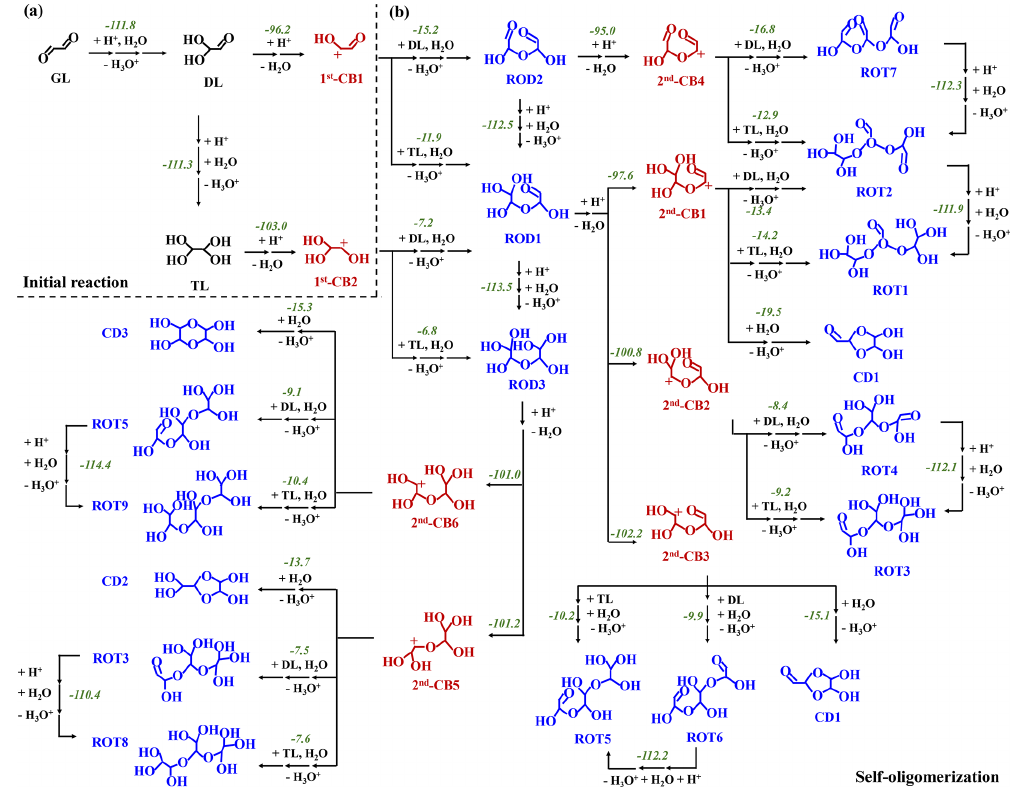
Figure 1. PES of the GL oligomerization without MA / AM (in kcalmol − 1 ): (a) the initial reactions of GL and (b) the subsequent oligomer- ization to dimers and trimers. The number denotes the total (cid:49)G r for each